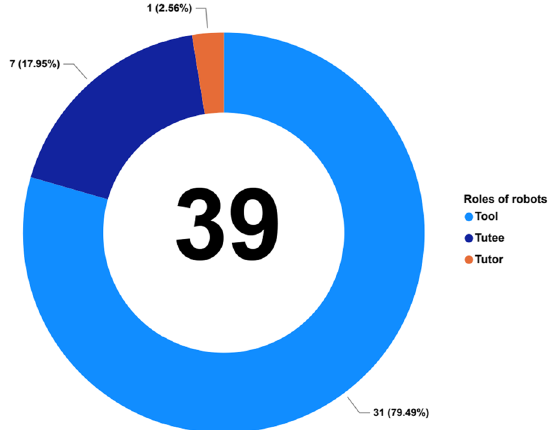
Fig. 9 Frequency of roles of